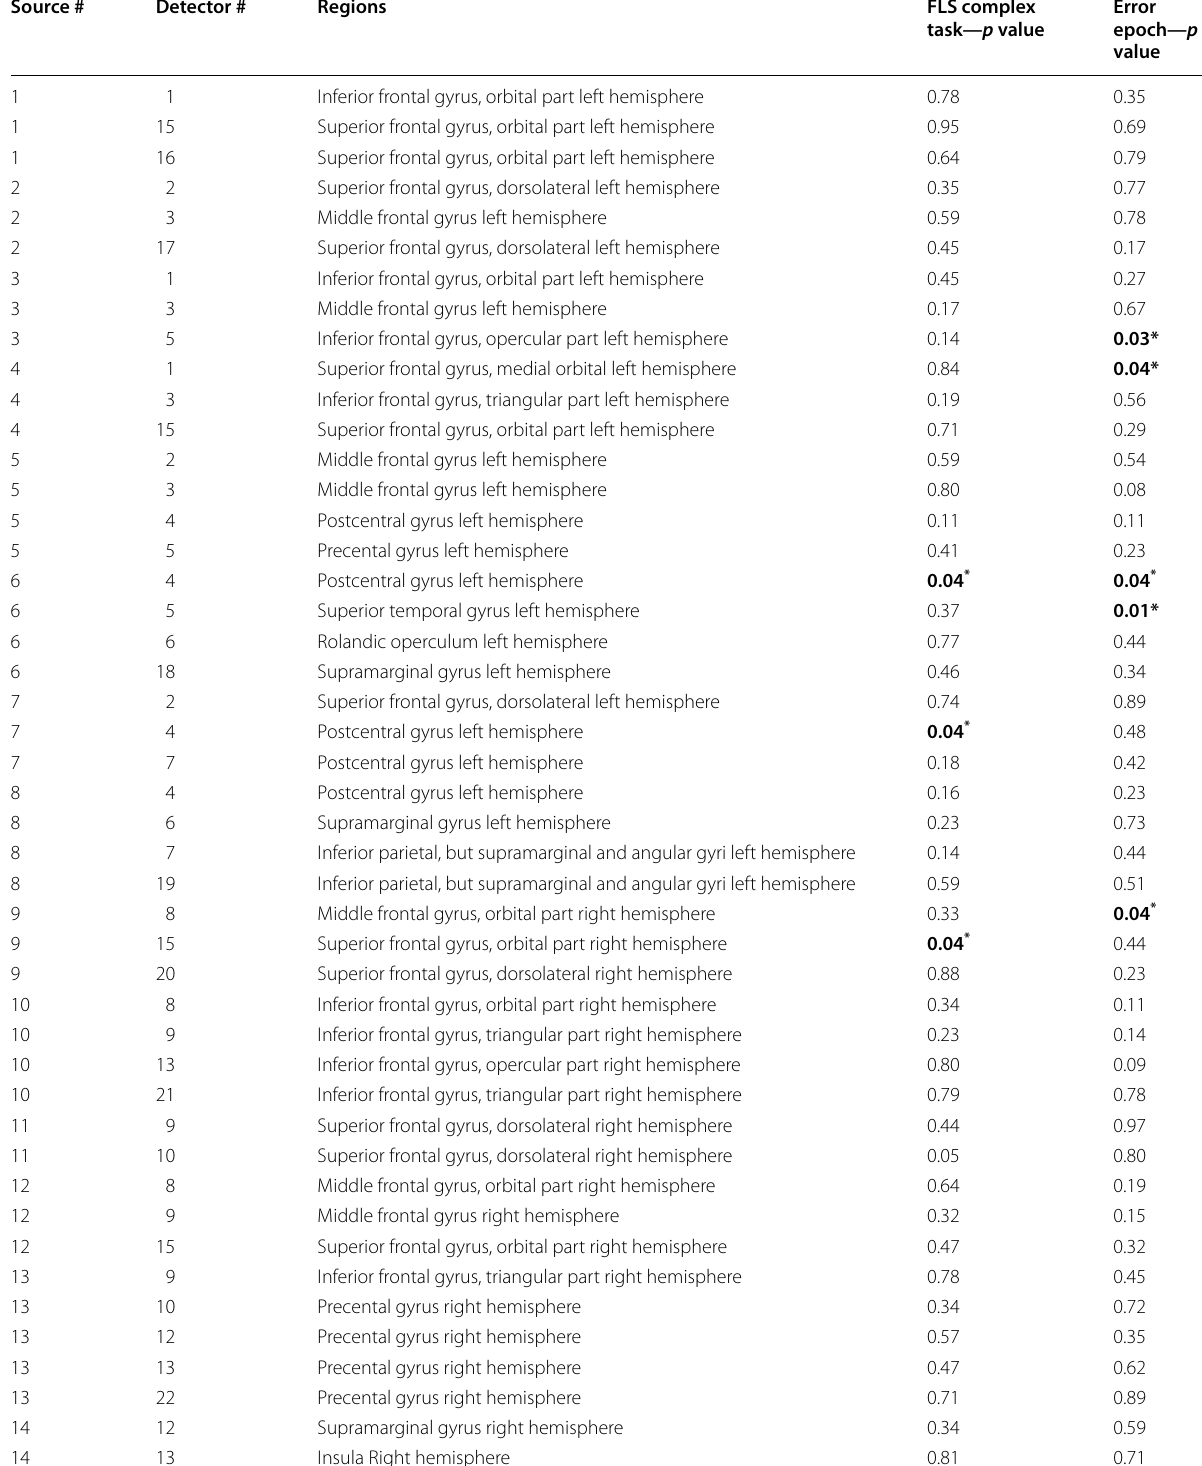
Table 2 Difference ( p value) in the hemodynamic (HbO) response across all fNIRS channels between the novices and the experts during 0 to 10 s at the start of the FLS complex task and in the error epoch. Automated anatomical labelling (AAL) of the cortical areas underlying fNIRS channels (source #–detector # pair) are also listed based on AtlasViewer’s default head model